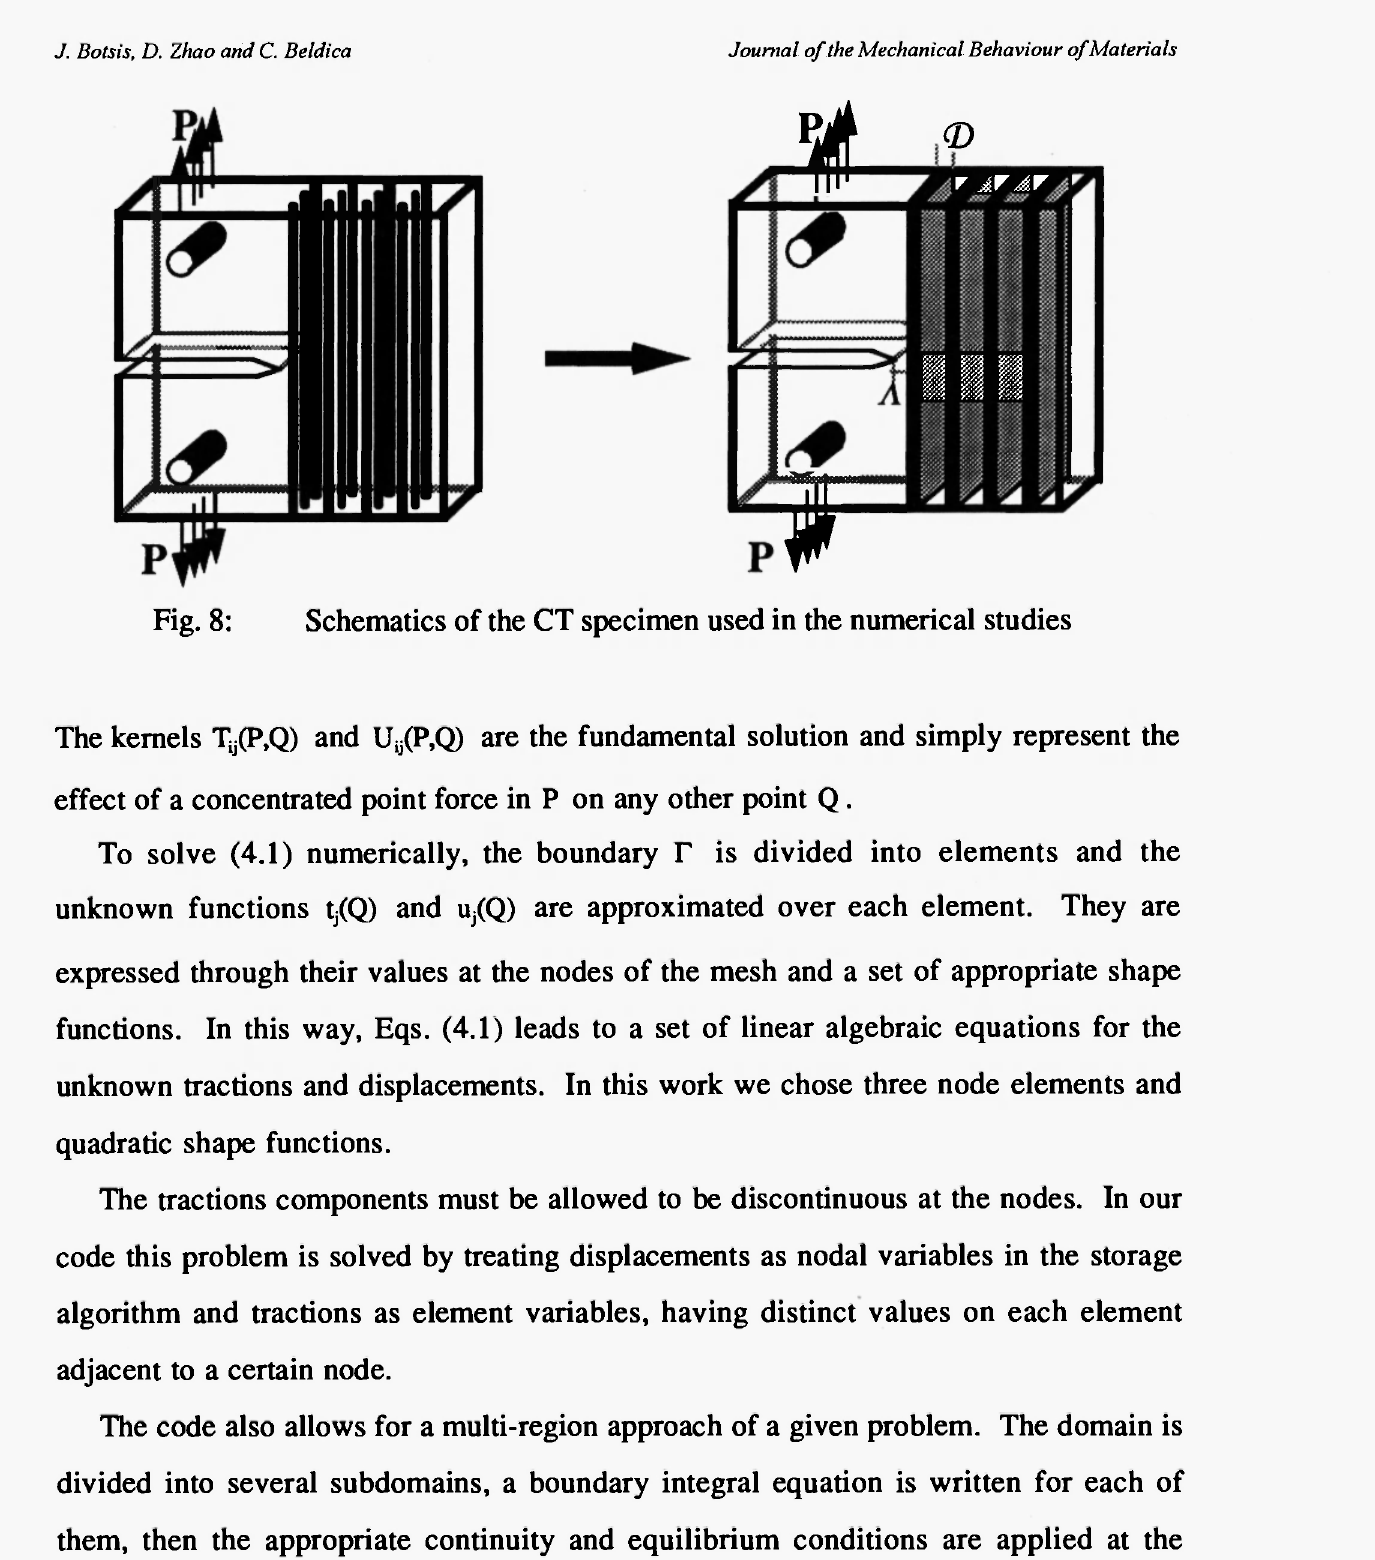
Fig. 8: Schematics of the CT specimen used in the numerical studies